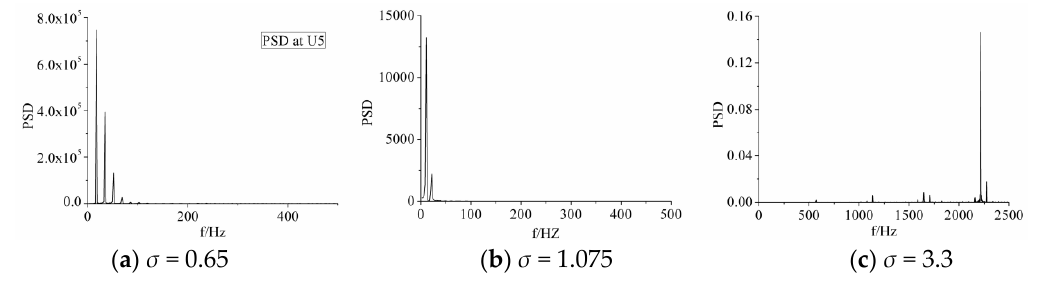
Figure 21. Acoustic power spectral density at U7 for σ = 0.65, 1.075, and 3.3.